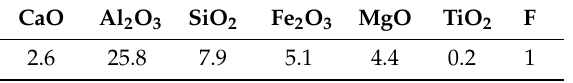
Table 4. Chemical composition of ladle slag (wt%).